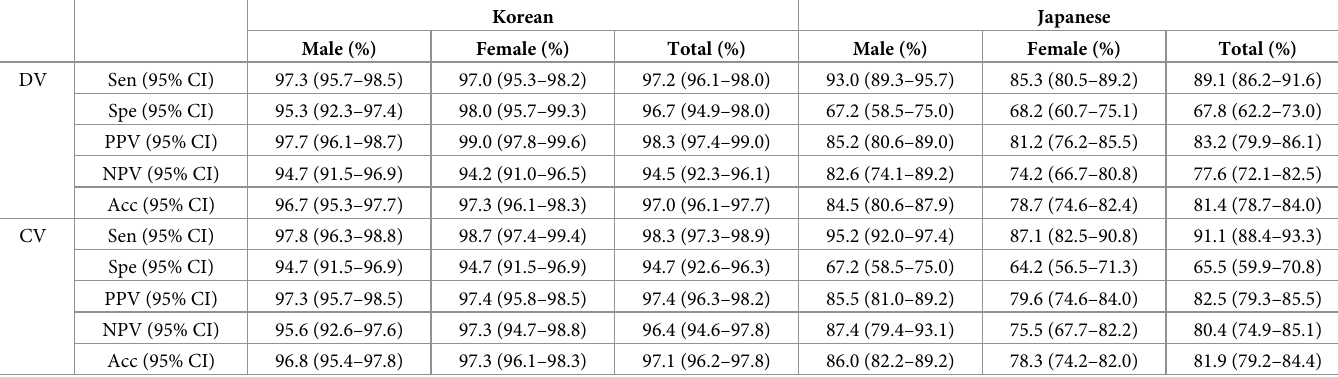
Table 5. Classification performance based on the 18-year